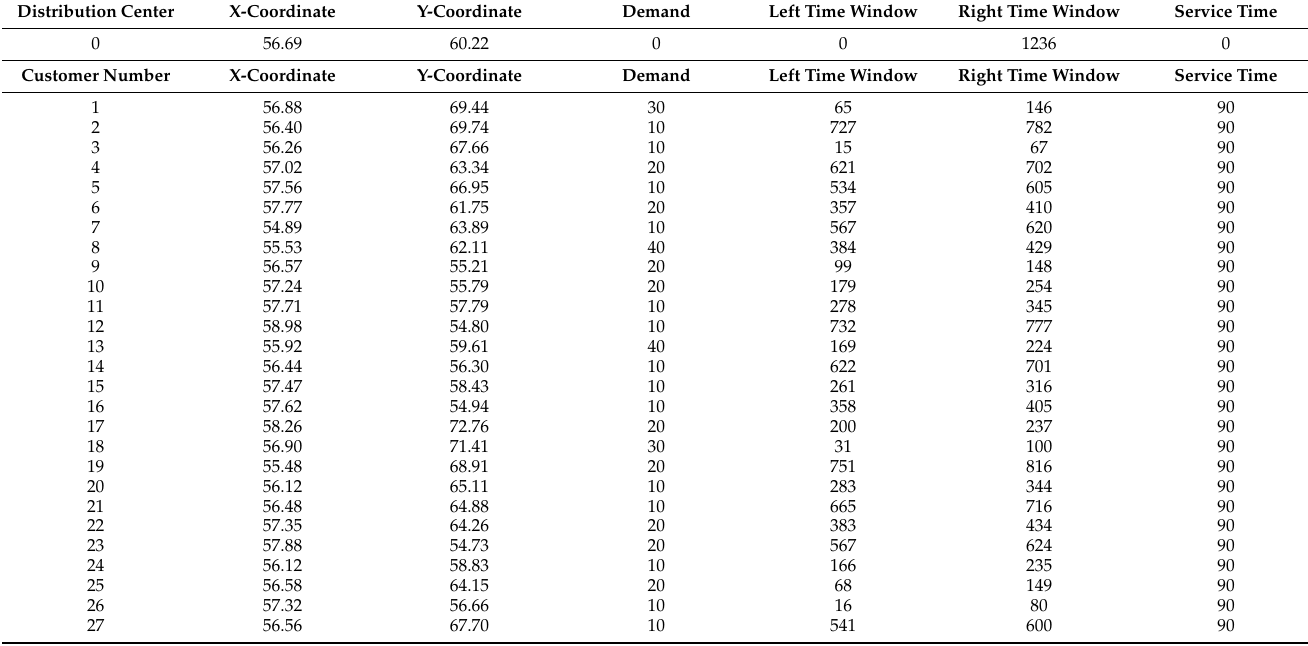
Table 5. The customer and distribution center node